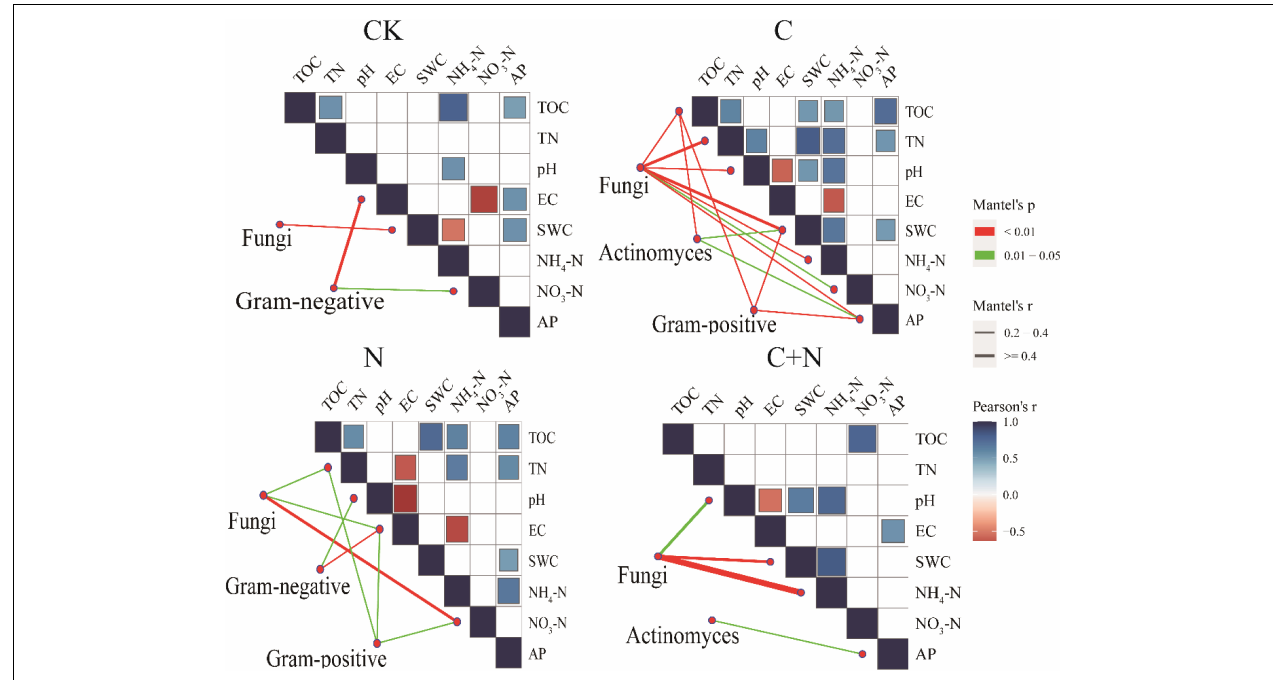
FIGURE 5 | Pairwise comparisons between environmental factors and microbial communities in the 0–10 cm and 10–20 cm soil layers by partial Mantel tests for different treatments. The color gradients denote Spearman’s correlation coefficients; line edge width corresponds to the Mantel’s r statistic for the corresponding distance correlations, and edge color denotes the statistical significance based on 9,999